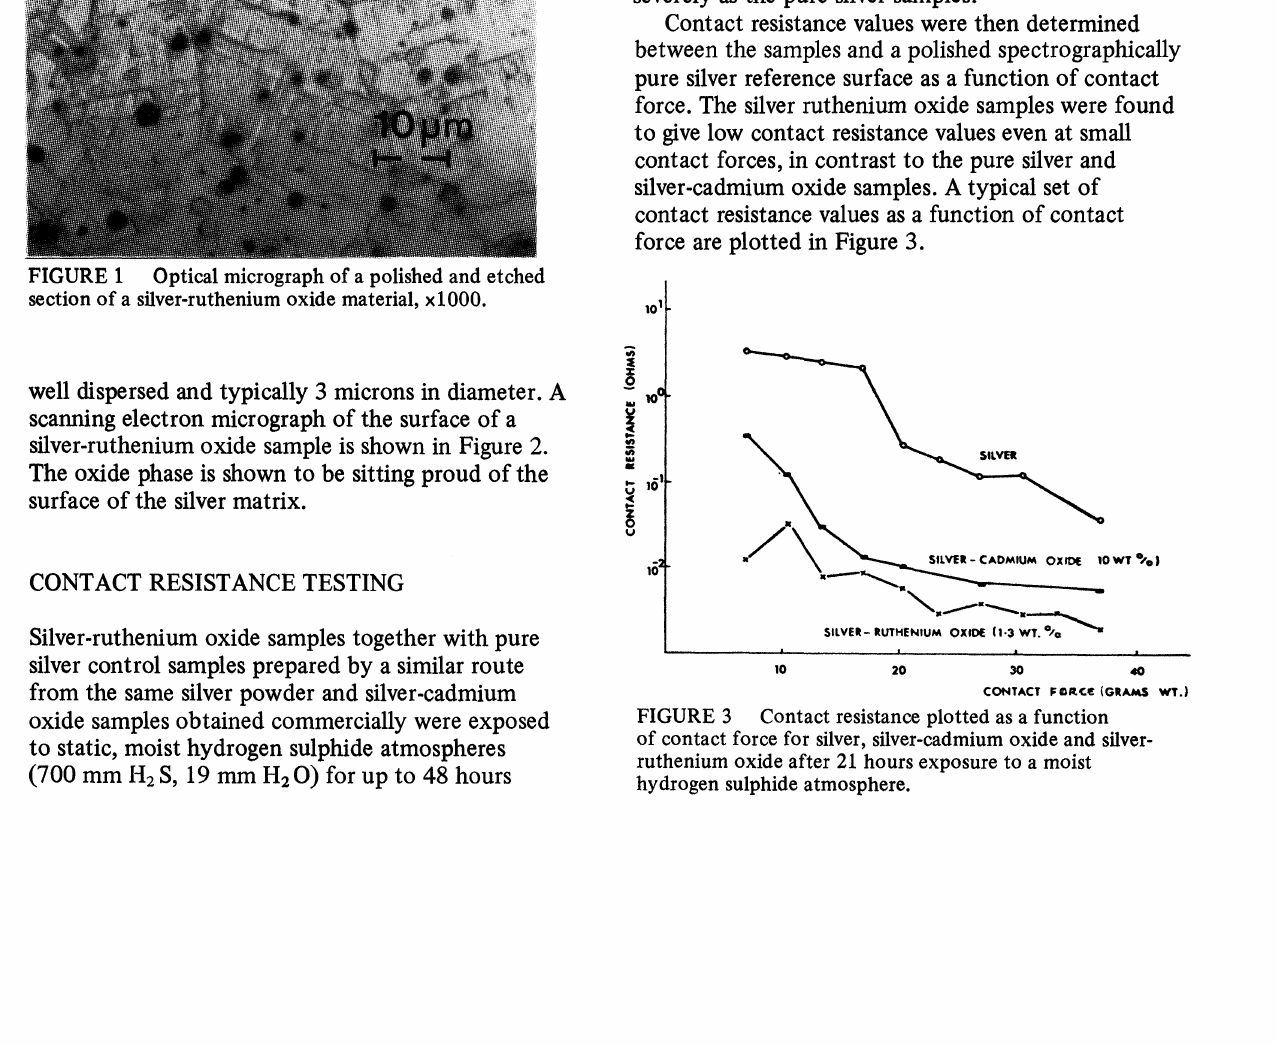
FIGURE 2 A scanning electron micrograph of the surface of a silver-ruthenium oxide material, x2000. at ambient temperature. Visual examination of the contacts after exposure revealed that the silver- ruthenium oxide samples had blackened just as severely as the pure silver samples. Contact resistance values were then determined between the samples and a polished spectrographically pure silver reference surface as a function of contact force. The silver ruthenium oxide samples were found to give low contact resistance values even at small contact forces, in contrast to the pure silver and silver-cadmium oxide samples. A typical set of contact resistance values as a function of contact force are plotted in Figure 3.